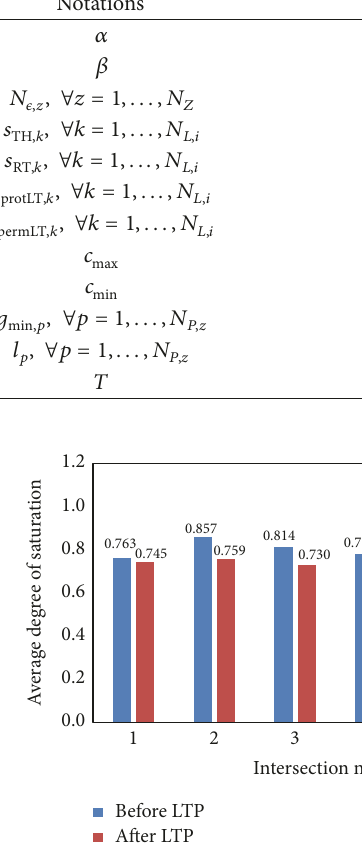
Figure 7: Average degree of saturation for each intersection before and after